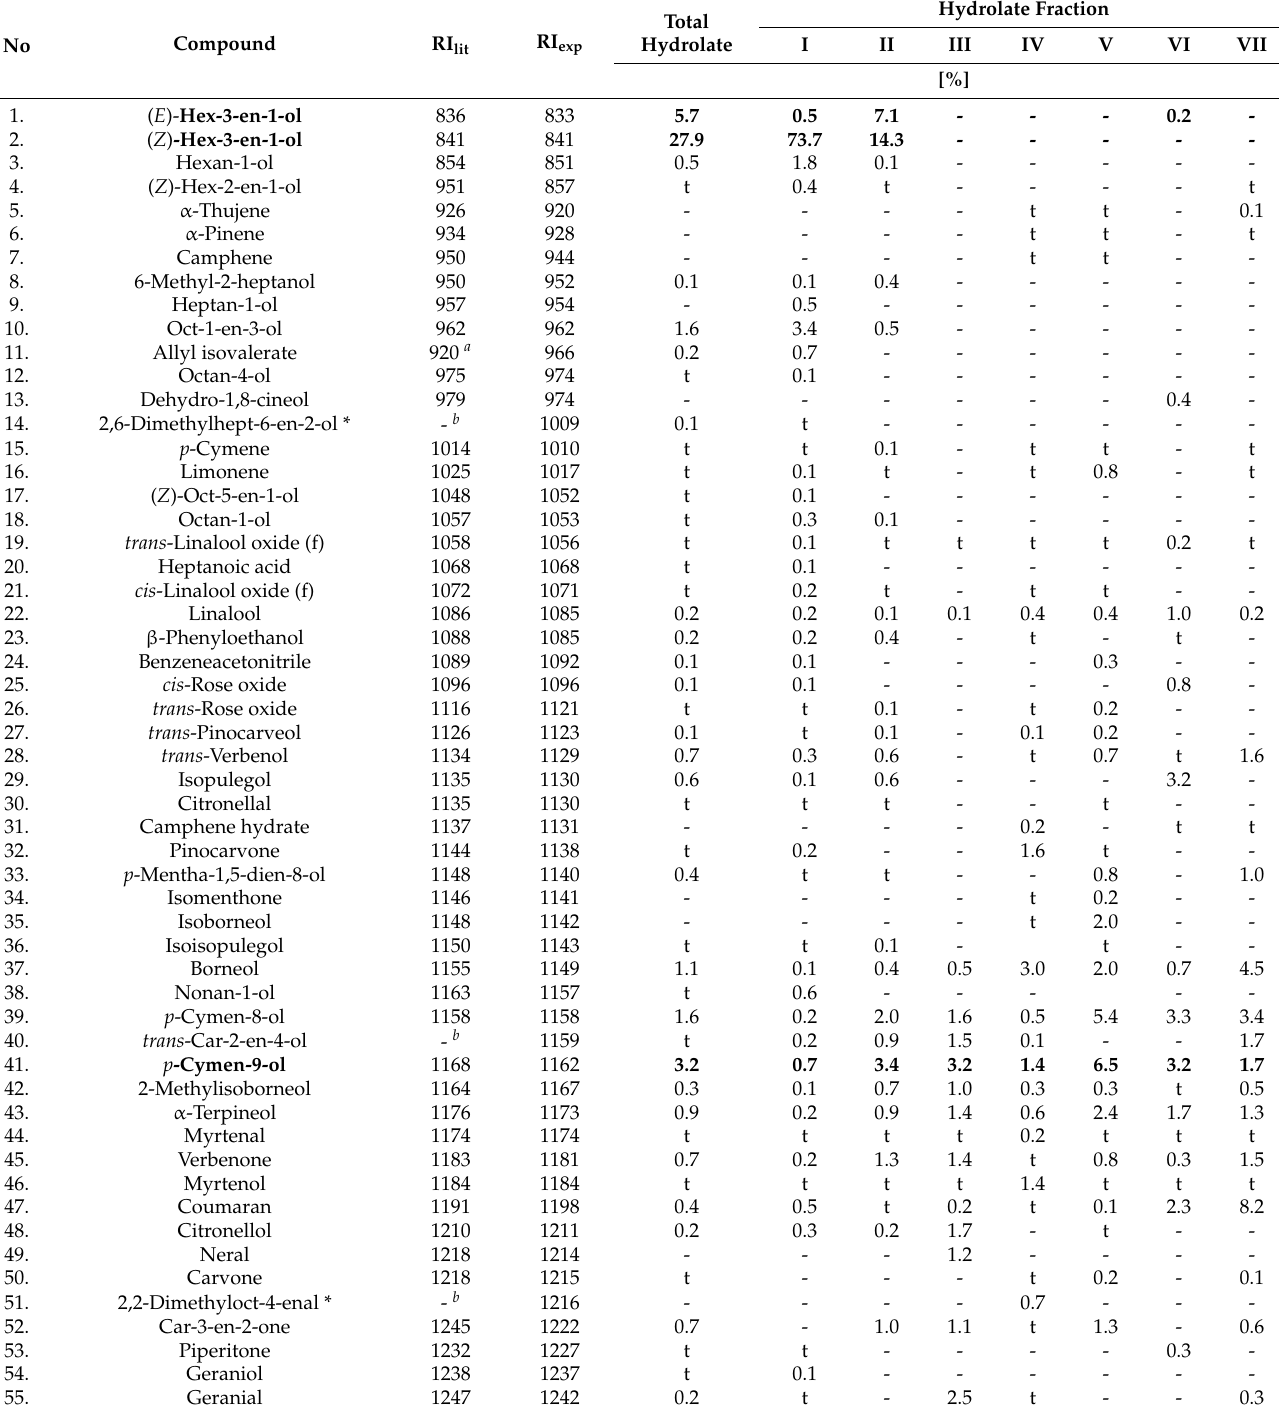
Table 1. Composition of stinging nettle ( Urtica dioica L.)